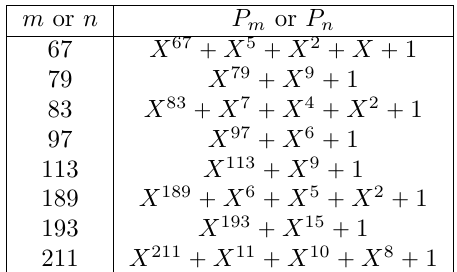
Table 2: The lists of P m ’s and P n ’s as polynomials in F 2